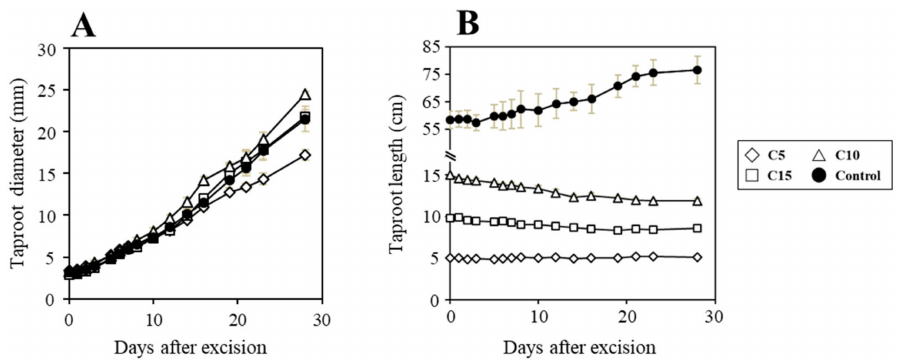
Figure 3. Time course changes in taproot diameter ( A ) and taproot length ( B ) of carrots after partial taproot excision. Vertical bars represent ± SE ( n = 4).